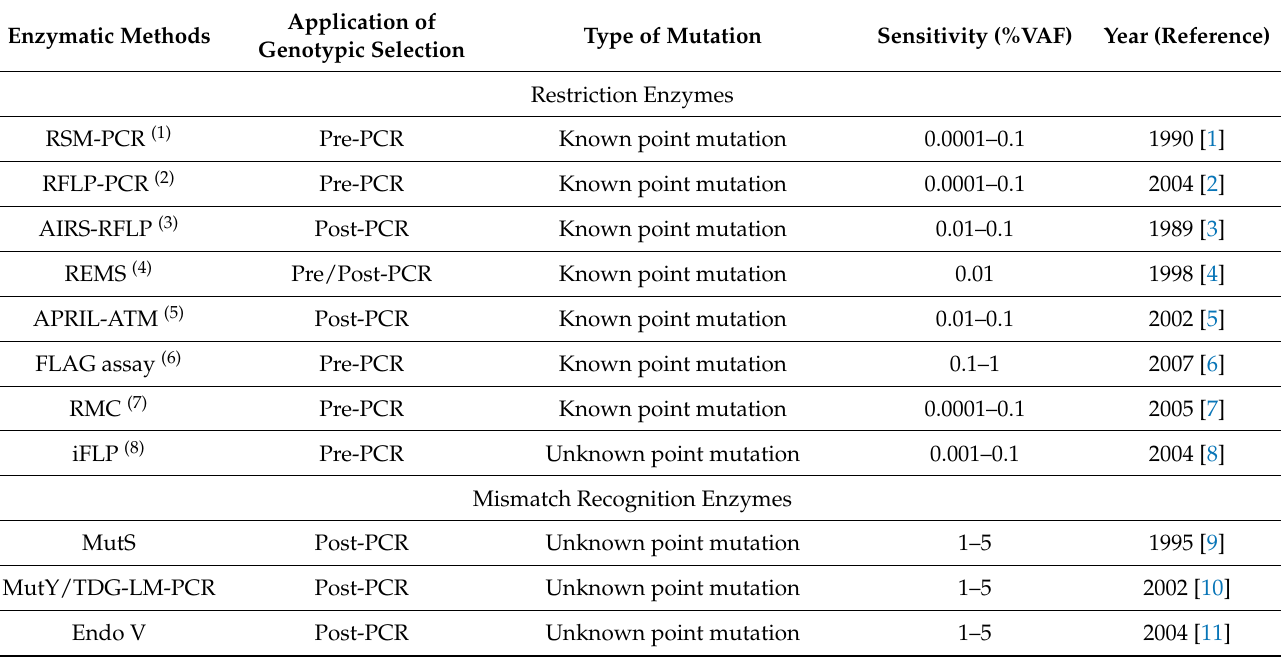
Figure 1. Schematic figure illustrating the concept behind the three different approaches of enzymatic mutation detection including restriction enzymes, mismatch recognition enzymes, and oligonucleotide-guided enzymes, including subsequent variations and enhancements for each method. Table 1. Enzymatic mutation enrichment and detection techniques. VAF: Variant Allele Frequency.